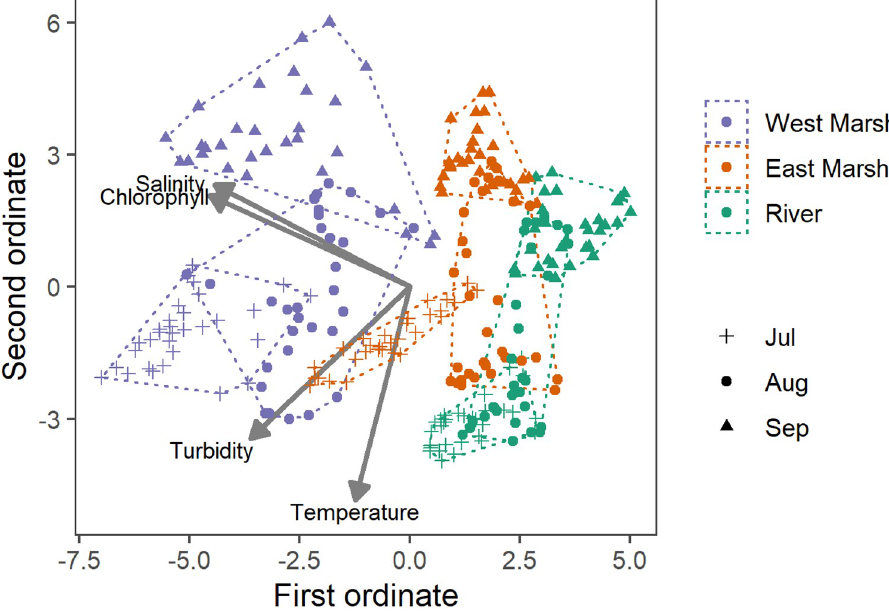
Fig 7. NMDS multivariate results for the three continuous water quality stations: River; East Marsh; and West Marsh. The results are grouped by month to show the seasonal changes. As noted in the text, the flow pulse action occurred primarily in August.